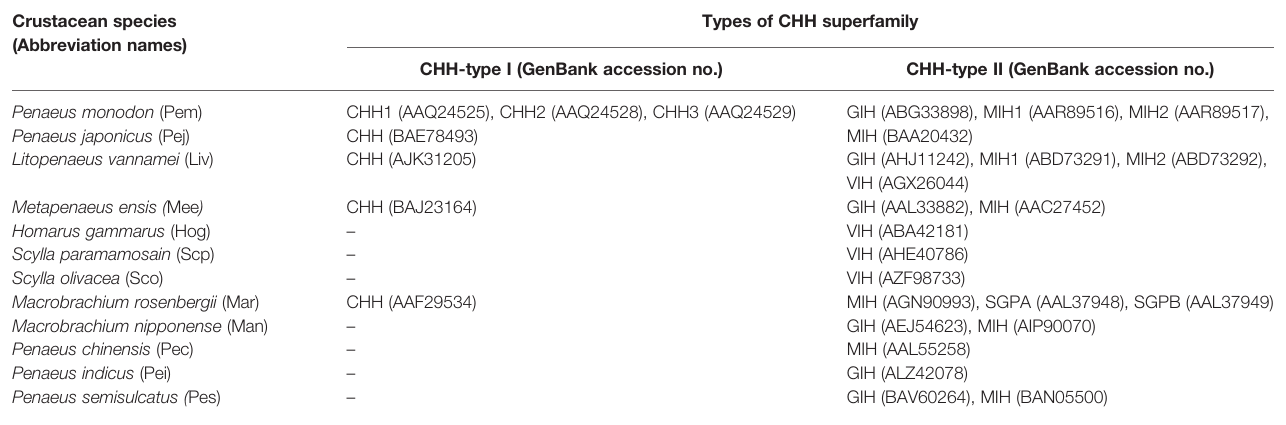
TABLE 2 | Accession numbers of CHH superfamily members obtained from GenBank database. Crustacean species (Abbreviation